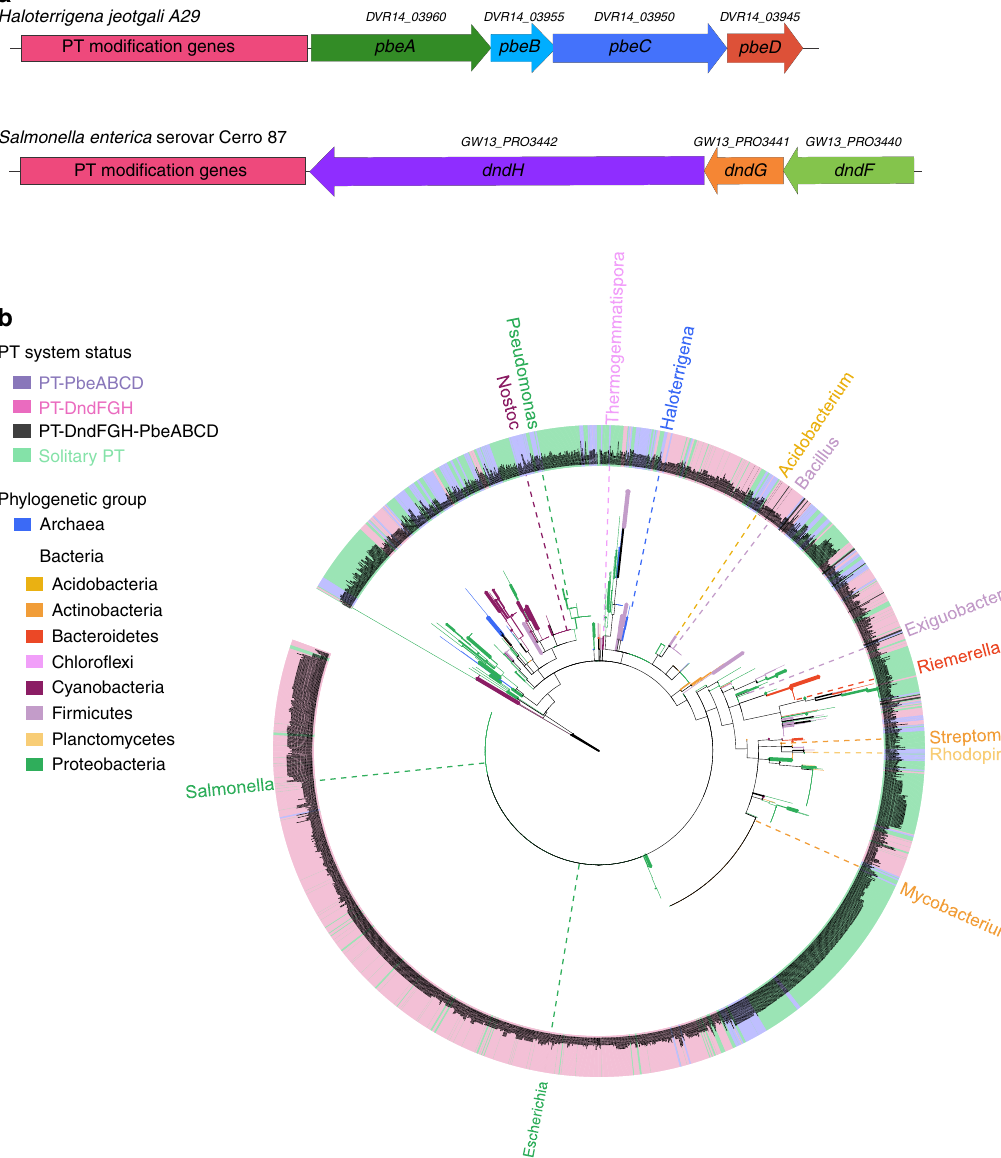
Fig. 3 The diversity of phosphorothioate (PT) systems in prokaryotes. a The genetic organisation and gene orders of the PT-based PbeABCD and DndFGH systems are displayed. GenBank accession numbers for pbeABCD in H. jeotgali A29 are indicated. b The phylogenetic tree of 2361 archaeal and bacterial DndCD homologues is colour-coded by phylogenetic group (see the legend). Strains shaded violet, pink, black and green have DndCD homologues associated with PbeABCD, DndFGH, DndFGH-PbeABCD, or none, respectively. The widths of tree branches are proportional to their Bootstrap scores. For clarity, at least one familiar genus per colour segment were labelled. Source data are provided as a Source Data fi